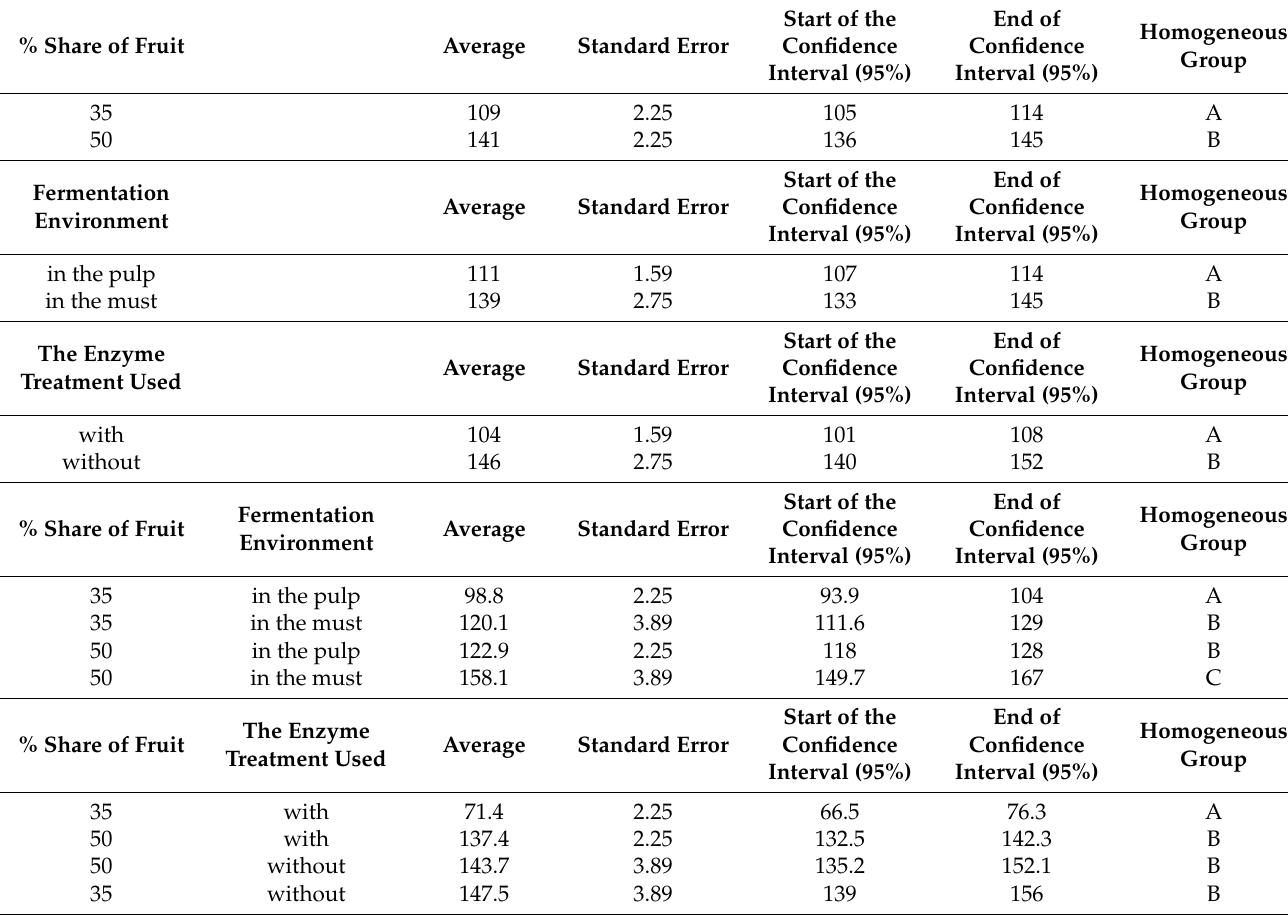
Table 3. Multivariate analysis of variance of the L-ascorbic acid content in wines after 3 months of aging on the share of fruit (a), fermentation in must or pulp (b), enzymatic treatment or its absence (c), and a combination of factors a * b and a * c.